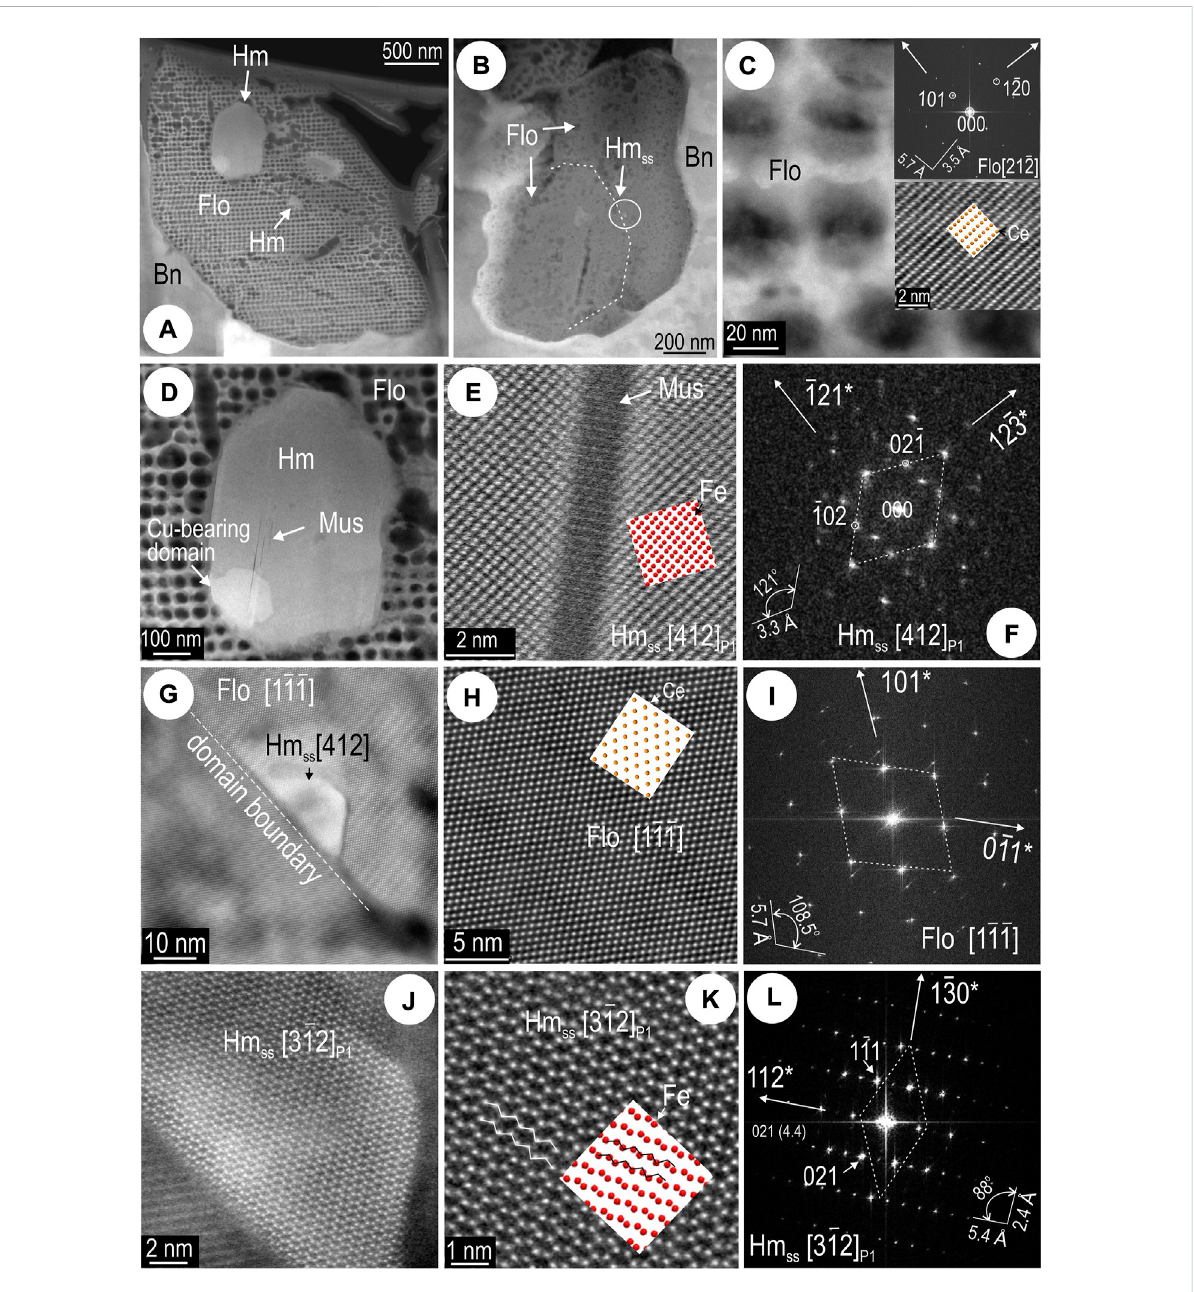
FIGURE 15 HAADFSTEMimagesof fl orencite(Flo)andhematite(Hm)fromsample10OD(foilHm#3).Zoneaxesgiveninsquarebracketsandatommodels asoverlays. (A) Largest and (B) smallesthematiteinclusions in fl orencite. (C) ImageandFFTpatternof fl orencite fromthegrainpartiallydecomposed in (A) . FFT pattern and image detail shown as insets. (D) Hematite [from (A) ] with nm-wide lamellae of muscovite (Mus). (E,F) High-resolution image and FFT patters showing superstructuring in hematite (Hm ss ) on the sides of the muscovite lamella [detail from (D) ]. (G) Hematite NP at domain boundary within fl orencite. (H,I) Atom-scale image and FFT pattern of host fl orencite. Images (J,K) and FFT pattern (L) showing that the hematite in the NP from (G) is the 2-fold superstructure (Hm ss